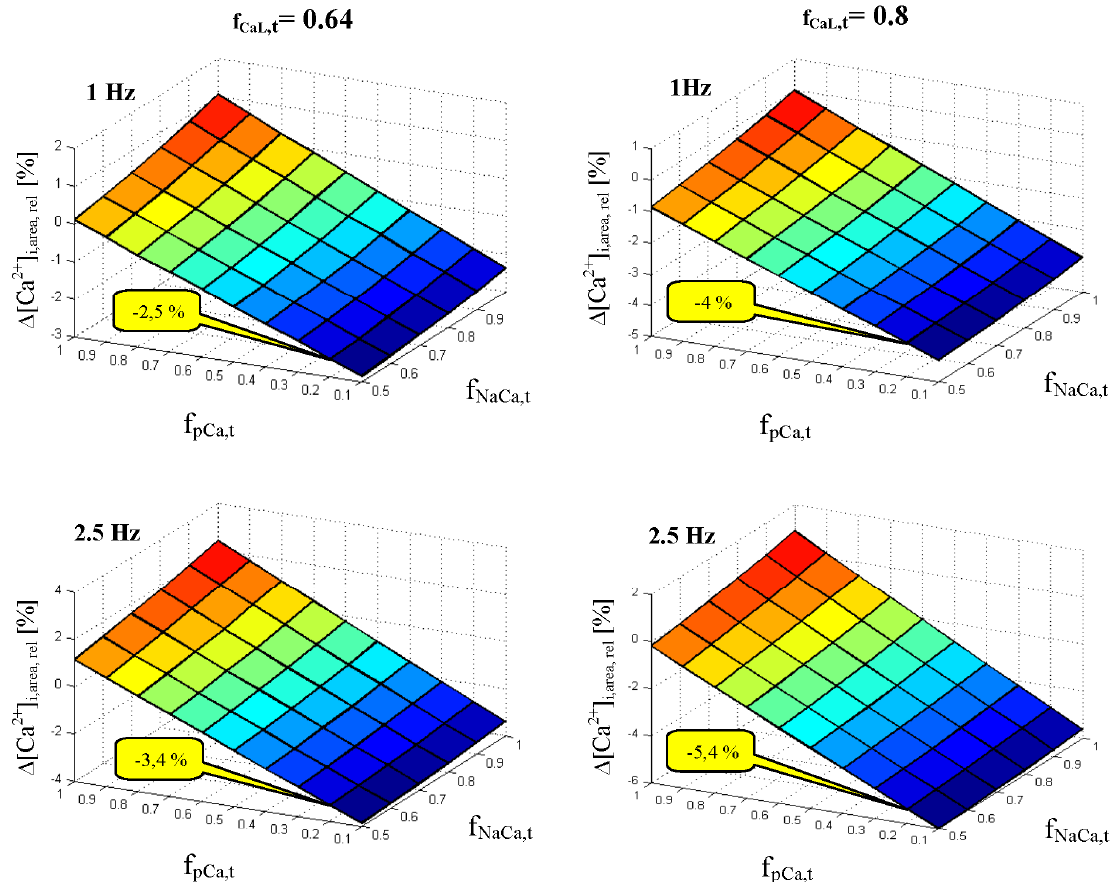
Figure 4. Effect of values of f and f on intracellular Ca 2+ -transient during a pCa,t NaCa,t steady-state cycle at f of 0.64 ( left panels ) and 0.8 ( right panels ). The upper CaL,t and bottom panels, respectively, show the results obtained at stimulation frequency of 1 and 2.5 Hz. The values in the yellow bubble indicate the percentage of the reduction of the cytosolic Ca 2+ -transient for basic adjustment of f and f (0.56 and 0.2, respectively). NaCa,t pCa,t represents the percentage change of the area delimited by cytosolic ∆ [Ca 2+ ] i,area,rel Ca 2+ -transient during a whole cycle relative to the area of steady-state Ca 2+ -transient in the model with extracellular ion concentrations fixed at external bulk